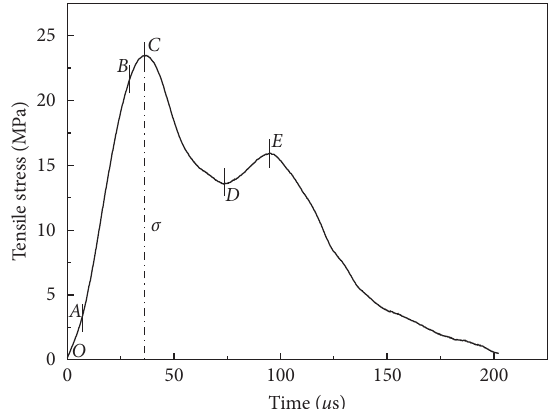
Figure 5: Different stages in the typical tensile stress-time curves of precentral holes discs